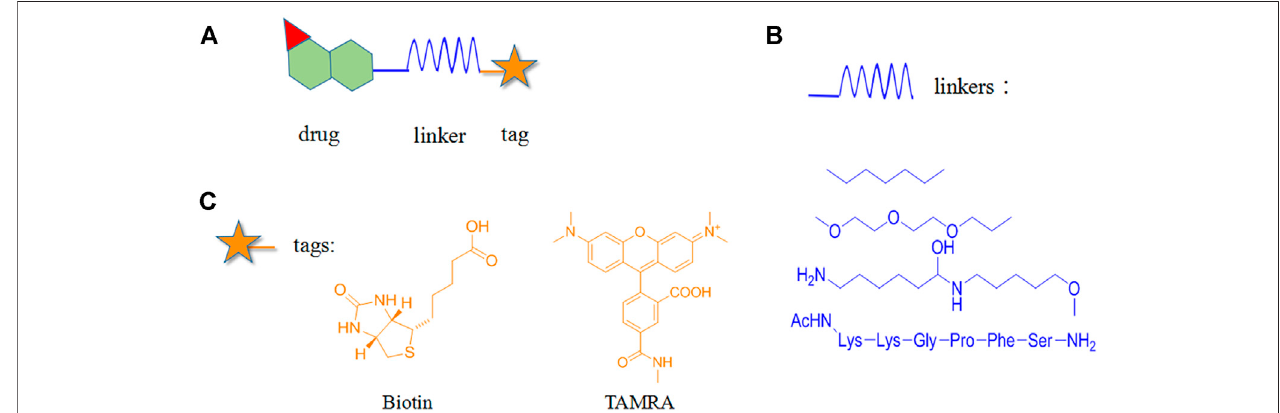
FIGURE 2 | Schematic diagram of the target hooking technique. The NP is fi rst structurally designed to be anchored to an insoluble support. Elution is performed after contact with the cell lysate, and the target proteins interacting with the af fi nity molecules are retained and identi fi ed by high-resolution mass spectrometry (MS).